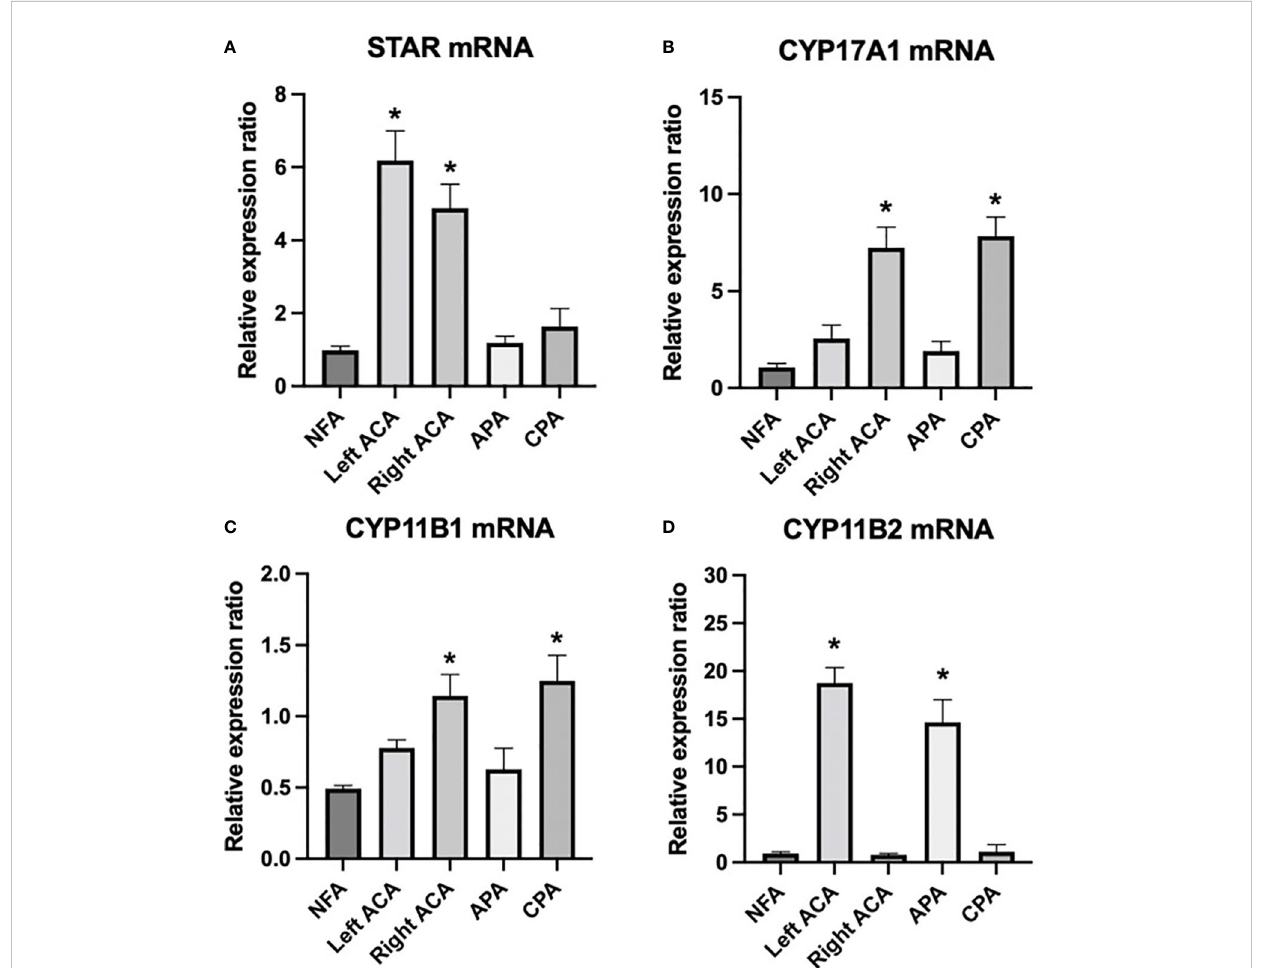
FIGURE 2 mRNA expression of steroidogenic enzymes STAR , CYP17A1 , CYP11B1 , and CYP11B2 in the bilateral adrenal adenomas of the patient and other adrenal adenomas. (A) STAR was highly expressed in both bilateral adenomas, (B, C) CYP11B1 and CYP17A1 were highly expressed in right adenoma and CPAs, (D) CYP11B2 was highly expressed in the left adenoma and APAs compared with other adrenal diseases and nonfunctional adenoma. * P < 0.05 compared with other groups. NFA, nonfunctional adenomas; left ACA, left adrenocortical adenoma of the index patient; right ACA, right adrenocortical adenoma of the index patient; APA, aldosterone-producing adenomas; CPA, cortisol-producing